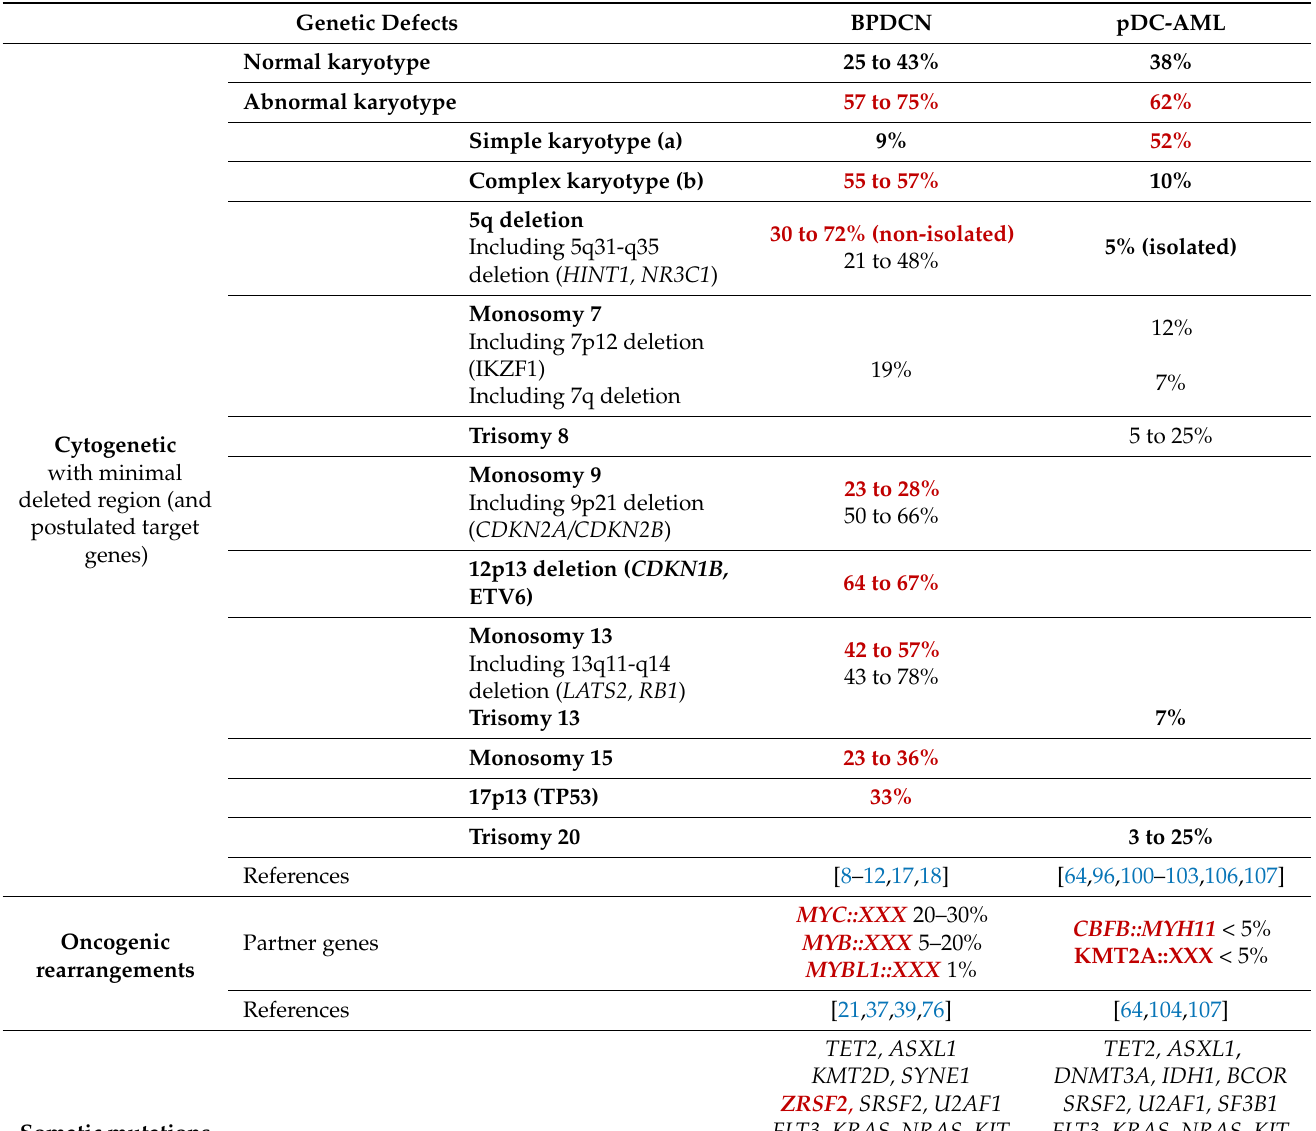
Table 1. Nature and frequency of cytogenetic and molecular aberrations in BPDCN compared to pDC- AML. (a) Simple karyotype: <3 cytogenetic abnormalities; (b) Complex karyotype: ≥ 3 cytogenetic abnormalities; mean number of cytogenetic abnormalities in BPDCN: 6.8; main defects are depicted in red; cytogenetic abnormalities are in bold while minimal deleted regions and postulated target genes are